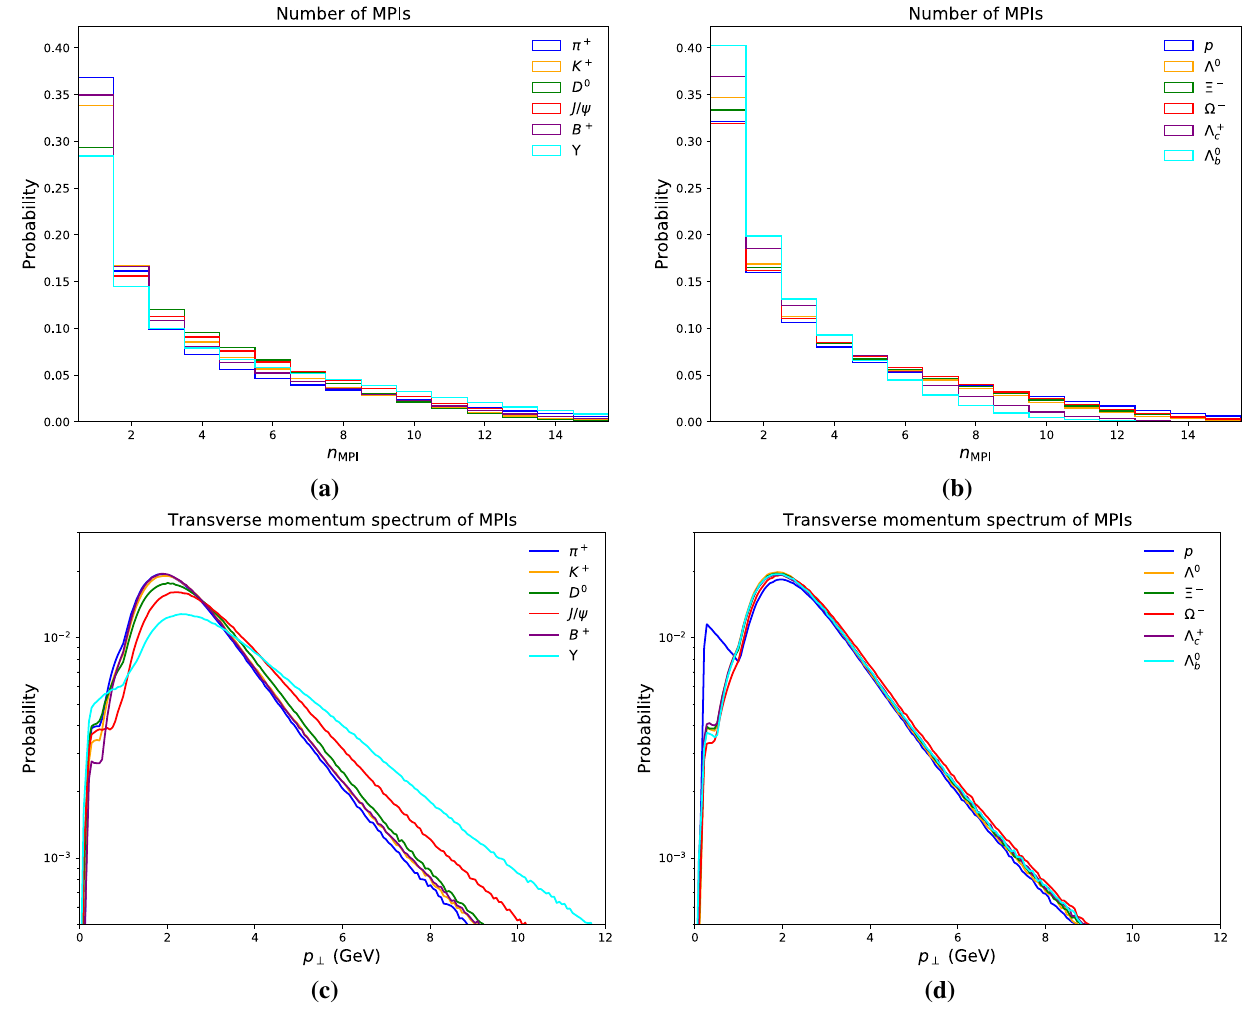
Fig. 6 The a , b number and c , d transverse momentum spectrum of MPIs, for a selection of a , c meson–proton and b , d baryon–proton col- lisions at 6 TeV. Labels denote the respective hadron beam. Note that